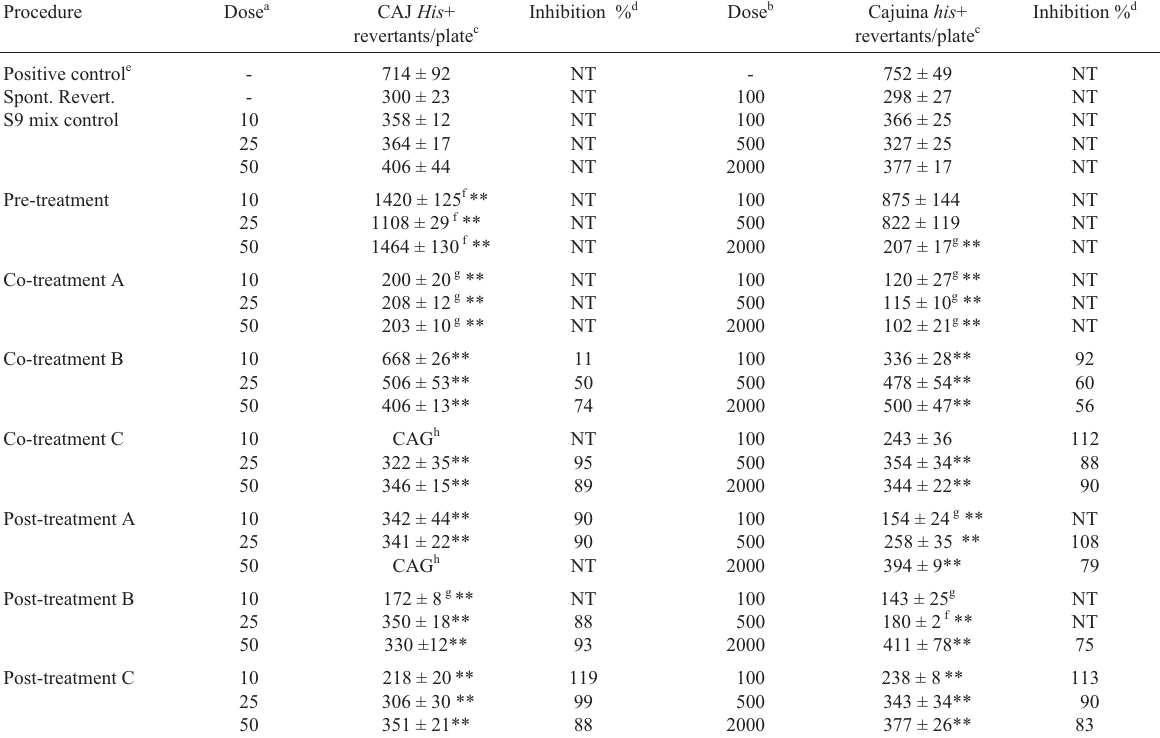
1 -induced mutagenesis in TA102 with metabolic